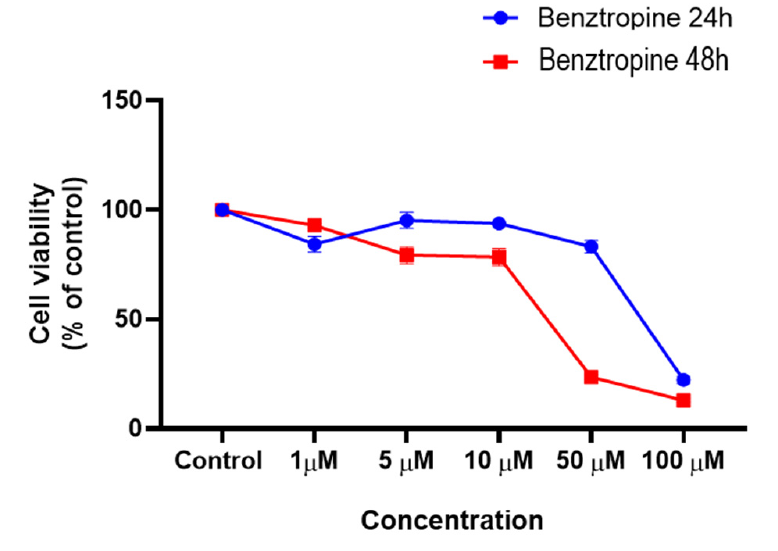
Figure 16. Comparison of the cell viability (% of control) between 24 h and 48 h of exposure. 3.5. Combinations of the Reference and Repurposed Drugs The repurposed drugs tested in MCF-7 cells with the most promising results for re- ducing cell viability were benztropine and thioridazine. Therefore, they were chosen to be used in combination with paclitaxel (the reference antineoplastic drug). 3.5.1. Paclitaxel and Benztropine Mesylate